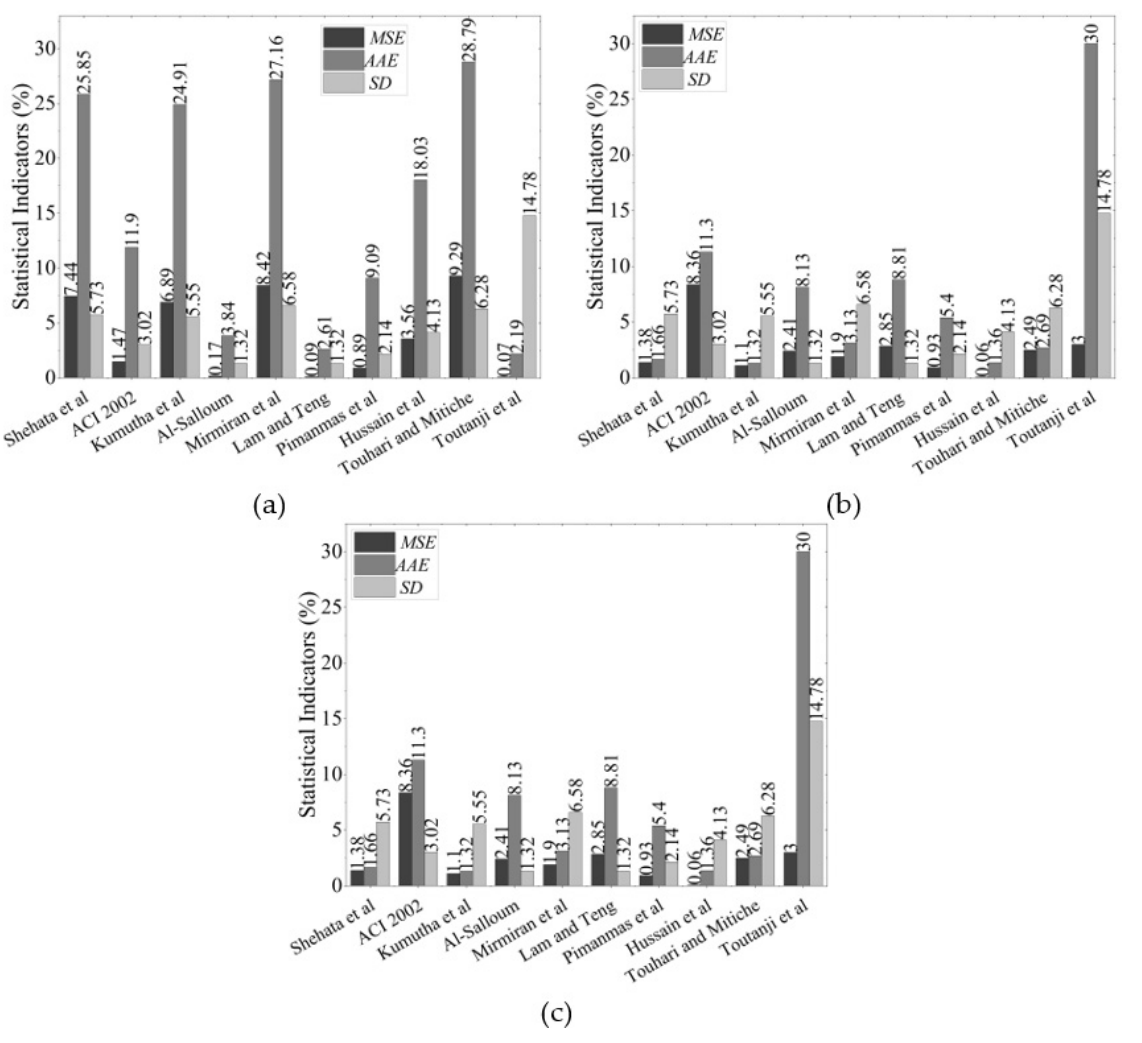
Figure 10. Statistical indicators to evaluate the performance of existing ultimate stress models ( a ) group 1, ( b ) group 2, and ( c ) group 3.